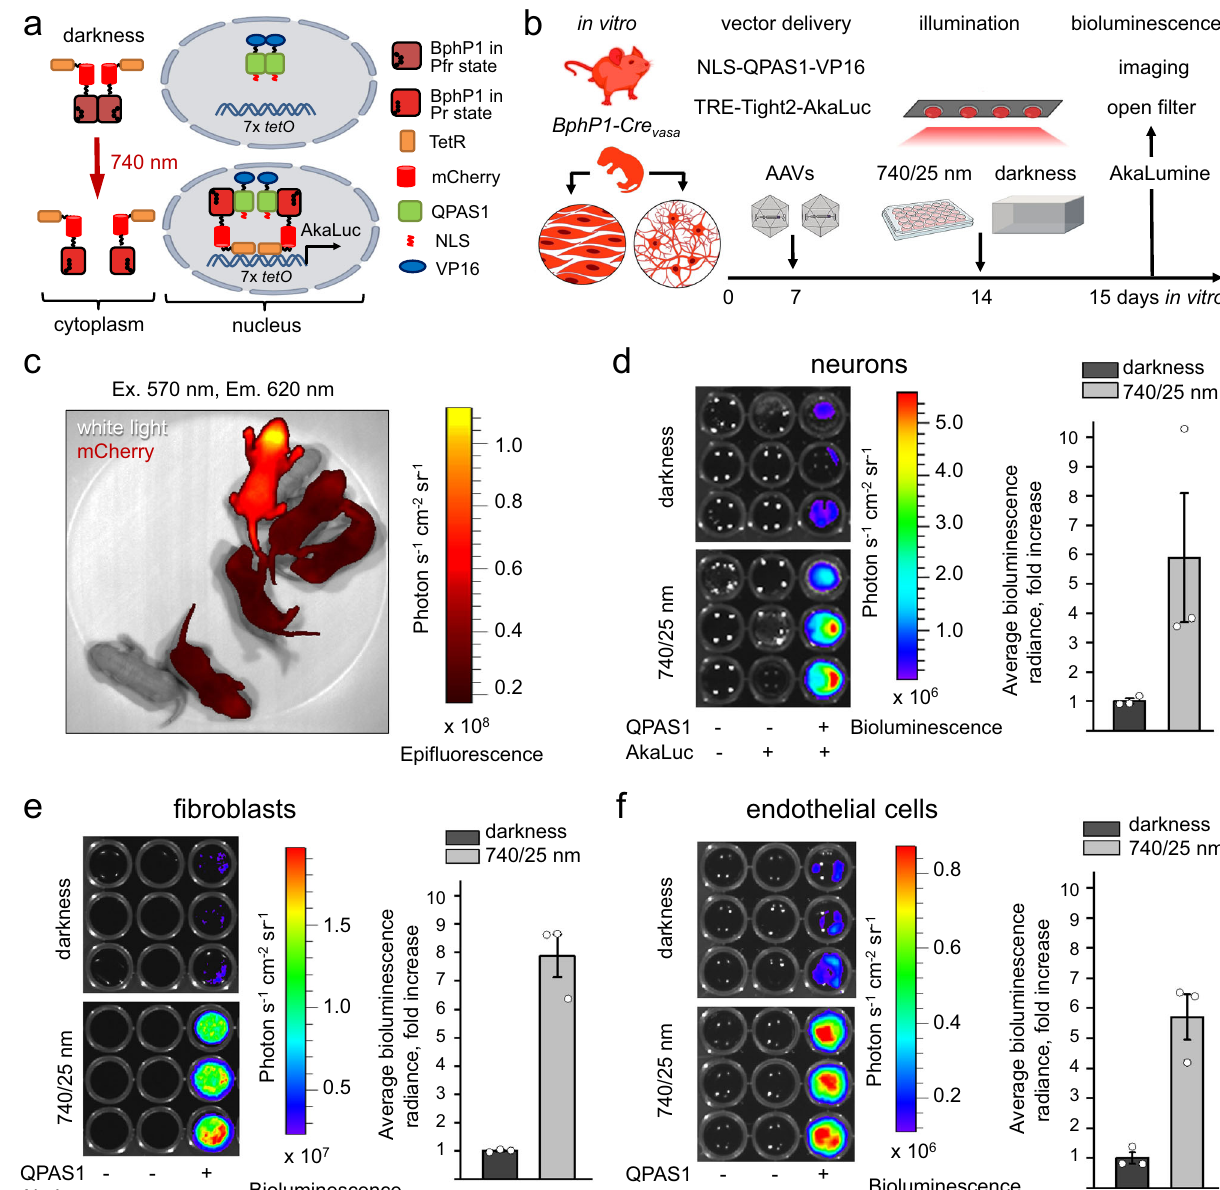
Fig. 3 Optogenetic activation of gene transcription in primary BphP1-Cre vasa derived cells. a Schematics of light-induced transcription activation. NIR light converts BphP1 into the Pr state and induces heterodimerization with QPAS1. NLS fused with QPAS1 facilitates translocation of the heterodimer to the nucleus, where BphP1 fusions interact with 7x tetO DNA repeats via fused TetR. VP16 fused with QPAS1 recruits the transcription initiation complex and triggers transcription of the AkaLuc reporter gene. b Experimental design for optogenetic transcriptional activation in vitro. Primary cultures were isolated from postnatal (P0-P1) homozygous BphP1-Cre vasa mice. On 7 day in vitro (DIV) cells were transduced with AAVs encoding CAG-NLS-QPAS1-VP16 and TRE-Tight2-AkaLuc (1:5, multiplicity of infection of 10 5 ). Seven days after viral transduction cells were illuminated with 740/25 nm light of 0.35 mWcm − 2 or kept in darkness for 24 h. c Selection of homozygous BphP1-Cre vasa pups based on mCherry fl uorescence using IVIS Spectrum imaging. Bioluminescence imaging of the light-induced AkaLuc expression in primary neurons ( d ), fi broblasts ( e ) and endothelial cells ( f ). Before imaging, the culture medium was aspirated, cells were transferred to a black 96-well plate in suspension and supplemented with AkaLumine (250 μ M). Visualization was performed in luminescence mode with an open emission fi lter. Fold increase of AkaLuc-evoked bioluminescence upon illumination with 740/25nm light was calculated following subtraction of signals produced by a reporter (TRE-Tight2-AkaLuc) only from values obtained with full-component OT. In ( d – f ) Data are presented as mean values + /- SEM ( n = 3; transfection experiments). For more details, see “ Statistics and reproducibility ” section of the Methods. Source data are provided as a Source Data fi were illuminated for 24 h by a 740/25 nm LED array (0.35 mW cm − 2 ) or kept in darkness.